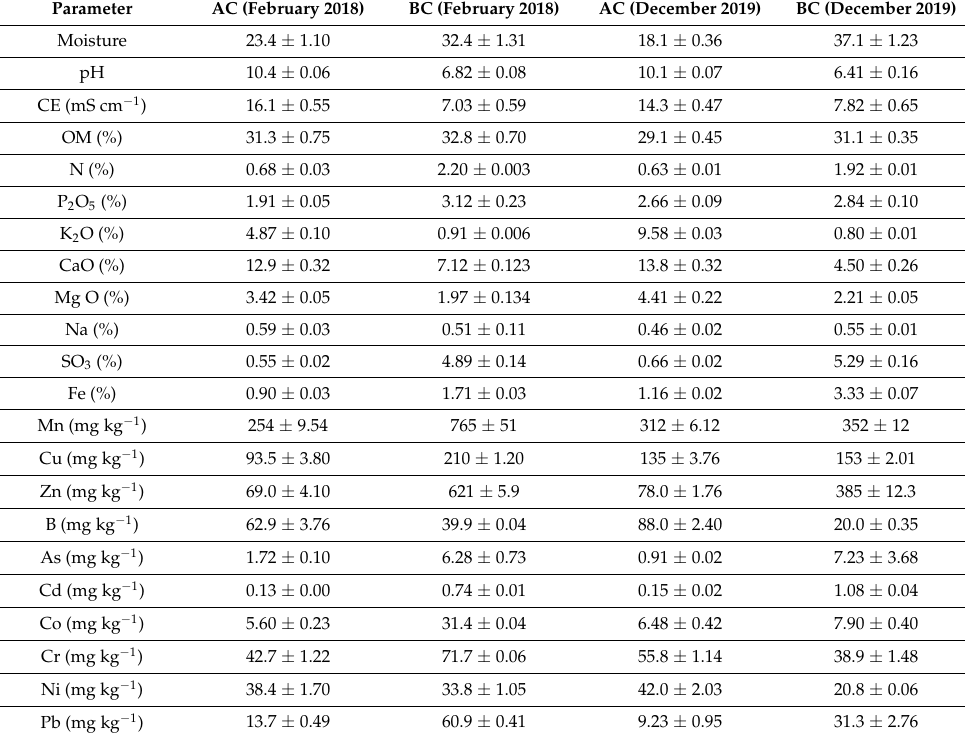
Table 1. Characterization of the compost used in this